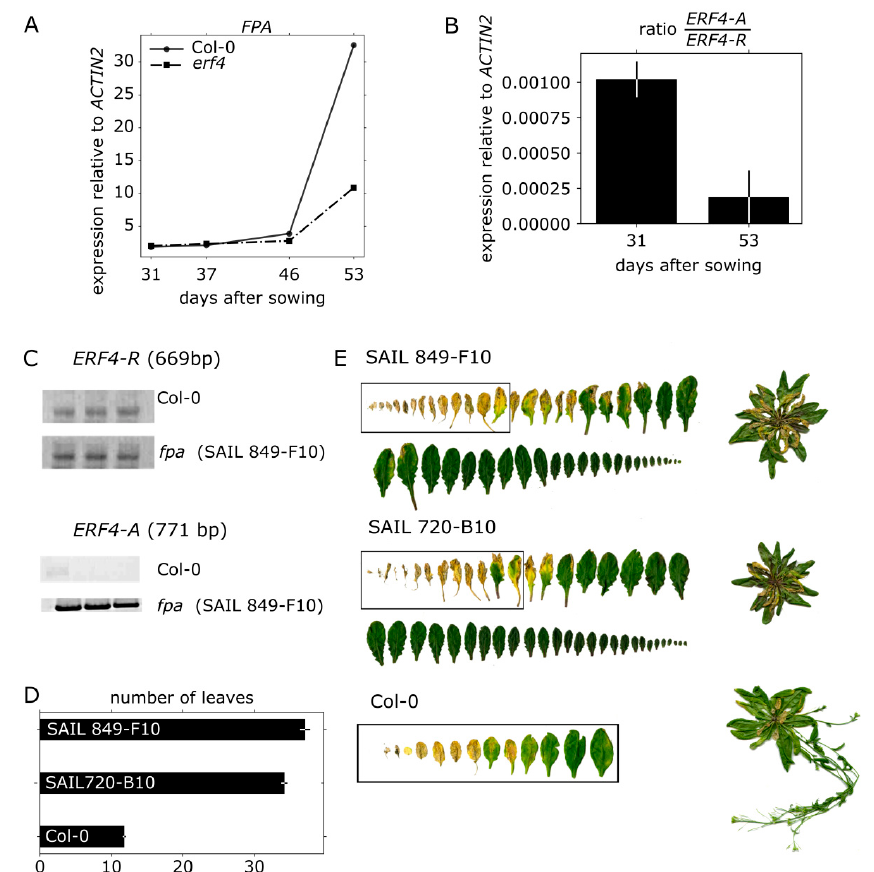
Figure 7. Characterization of fpa plants. ( A ) qRT-PCR data shows expression level of FPA in Col-0 and erf4 plants relative to ACTIN2 . Leaves No. 7 of 5 biological replicates were pooled. Data are means of two technical replicates. ( B ) Ratio between ERF4-A and ERF4-R mRNAs at early (31 DAS) and late stages of development (51 DAS) ( C ) Semi-quantitative-PCR (sqRT-PCR) with RNA isolated from a pool of 10 plants was performed. Images show representative bands on a 1% agarose gel for ERF4-R (27 cycles, 2 µl cDNA , 669 bp) and ERF4-A (36 cycles, 3 µl cDNA, 771 bp) in Col-0 and fpa (SAIL 849-F10) plants of three technical replicates. ( D ) Number of rosette leaves 6 weeks (42 DAS) after sowing of fpa and Col-0 plants. Error bars indicate ±SE, n = 10. ( E ) Representative pictures of rosette leaves sorted according to their age 7.5 weeks (51 DAS) after sowing of two fpa lines (SAIL 849-F10 and SAIL 720-B10) and Col-0.